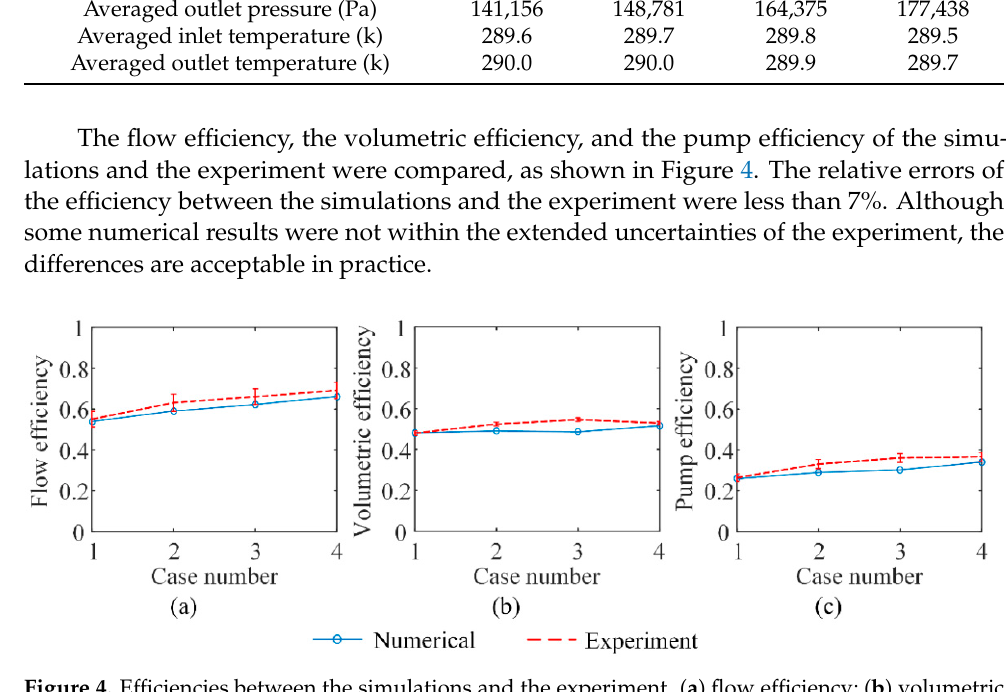
Figure 4. Efficiencies between the simulations and the experiment. ( a ) flow efficiency; ( b ) volumetric efficiency; ( c ) pump efficiency. Reprinted with permission from ref. [7]. Copyright 2020